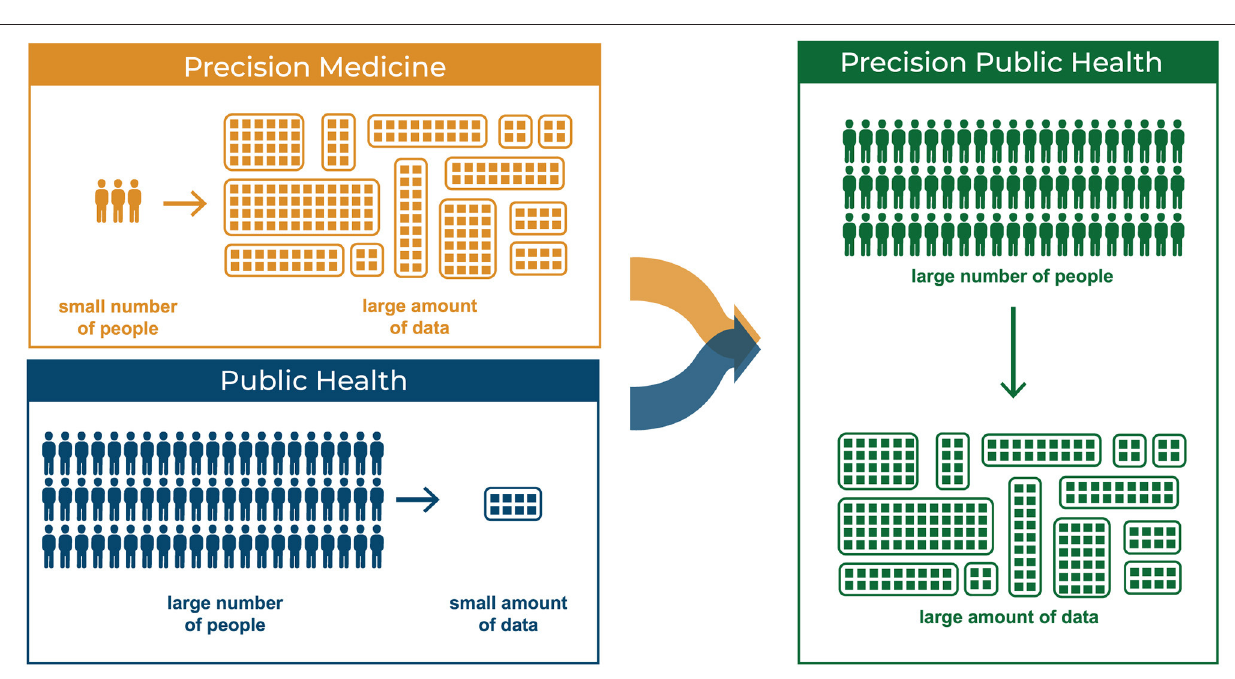
and Signal Detection, Risk Prediction, Targeting